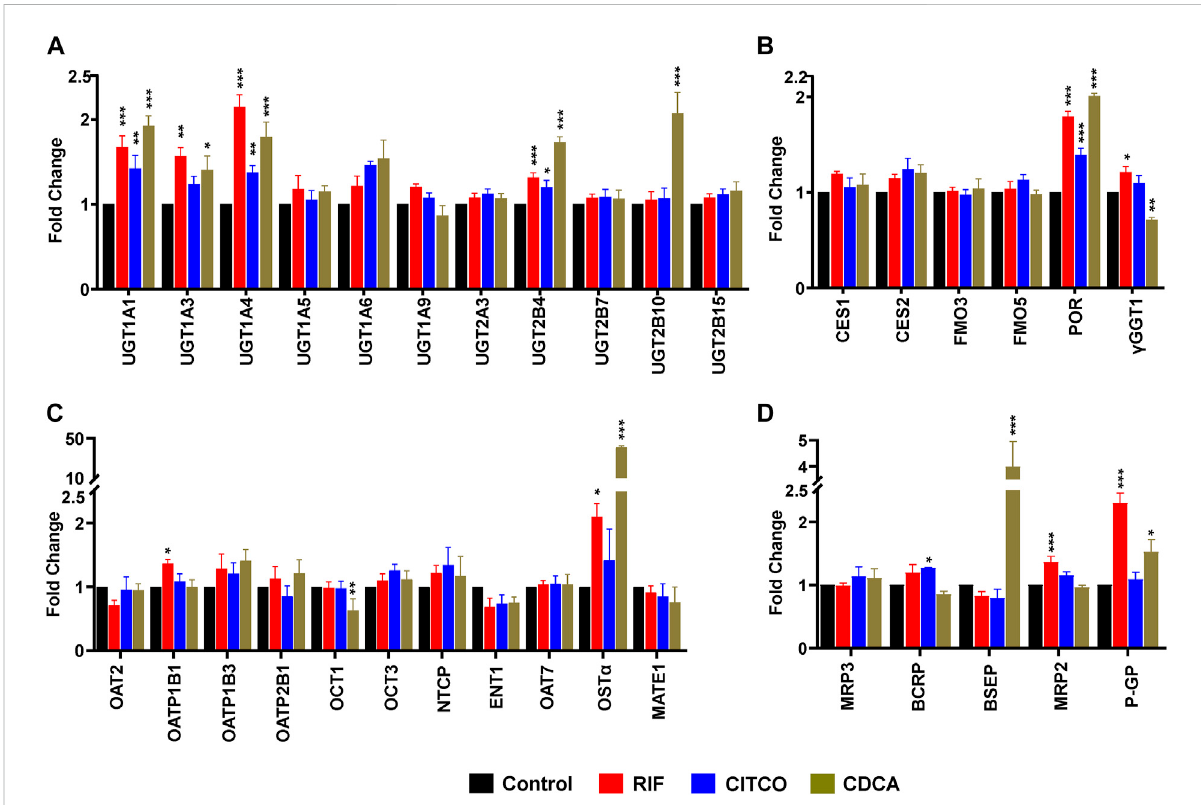
FIGURE 2 NuclearreceptoractivatorinducedalterationsinDMEandtransportproteinconcentrationinSCHH.Absoluteproteinconcentrationof11UGTs (A) , six other DMEs (B) , 11 SLC transport proteins (C) , and fi ve ABC transport proteins (D) were quanti fi ed in SCHH from fi ve quali fi ed in hepatocyte donors following exposure to vehicle control, rifampicin (RIF, 10 µM), CITCO (1 µM), or chenodeoxycholic acid (CDCA, 100 µM) for 72 h. The experiment in each hepatocyte donor included three to four biological replicates, and mean fold-change was computed for each protein relative to the vehicle control group within each donor. The data re fl ect the mean ± SEM fold-change for each protein relative to control across donors ( n = 5 per group). * p < 0.05, ** p < 0.01, *** p < 0.001 versus